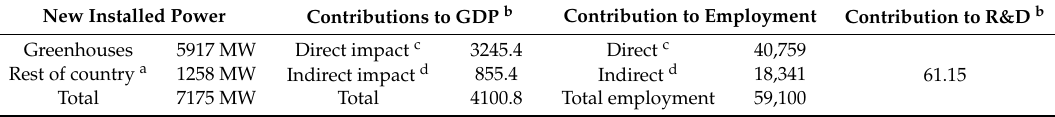
Table 7. Impact on GDP, employment and R&D: forecasts for 2020. Estimates based on